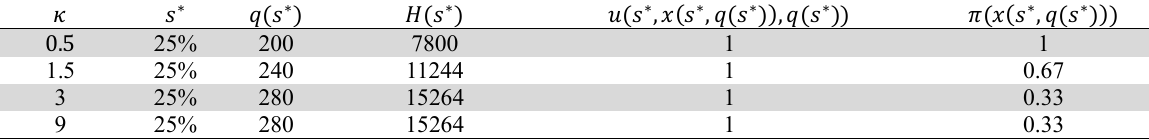
Solutions of the proposed model with 𝜑 = 3